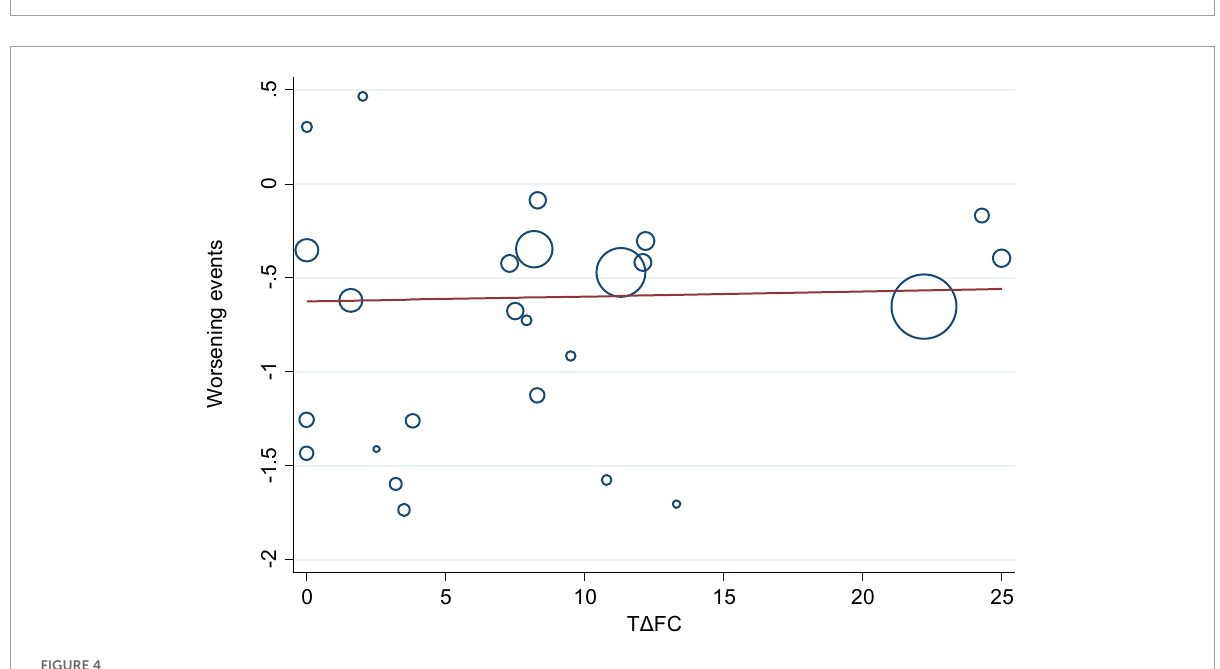
FIGURE4 Meta-regression analysis of change in functional class from baseline ( (cid:49) FC) and clinical worsening events